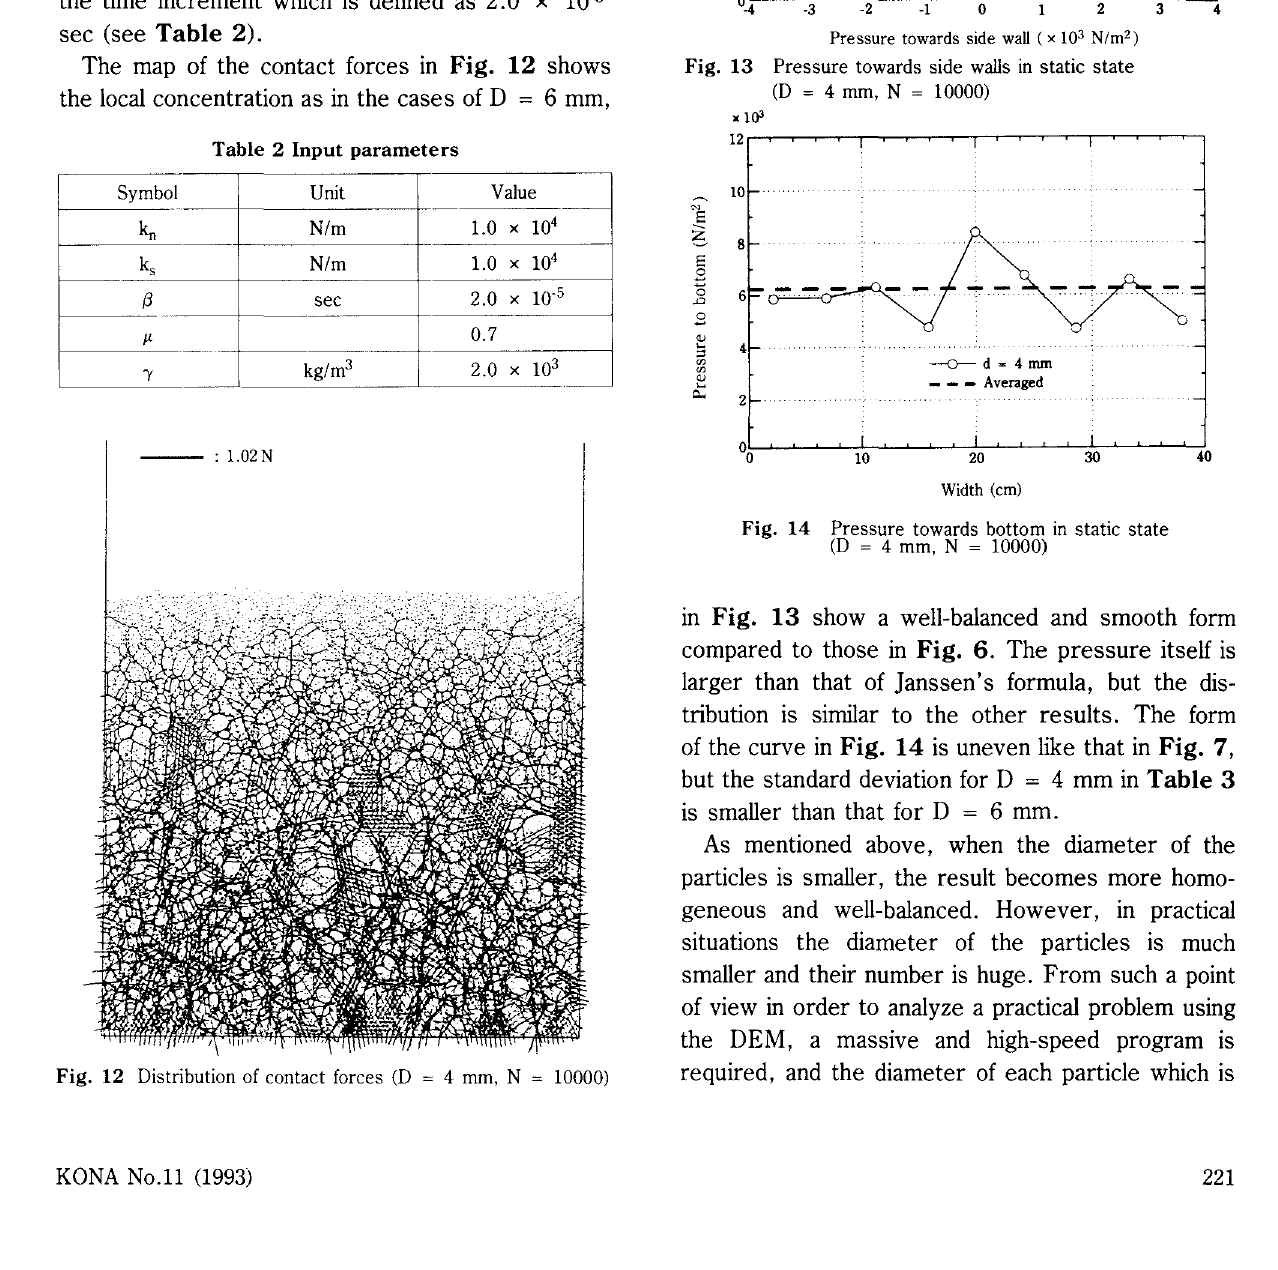
Fig. 13 Pressure towards side walls in static state